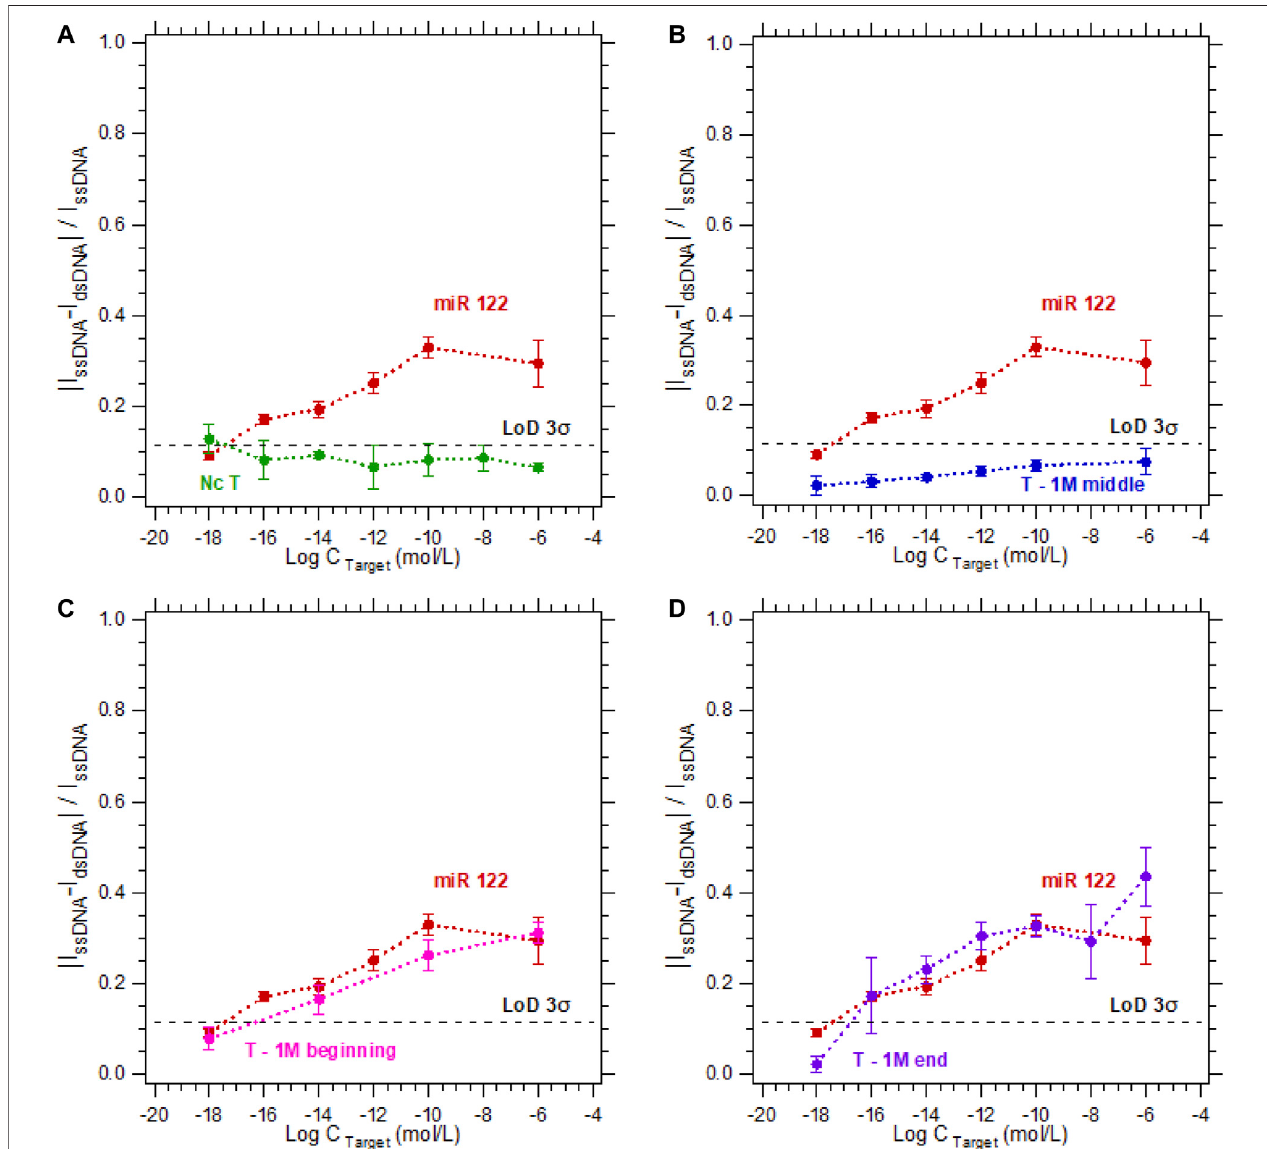
FIGURE 3 | Calibration curves in 3 mM [Fe (III) (CN) 6 ] 3 − /[Fe (II) (CN) 6 ] 4 − and 0.5 M NaCl for the detection of DNA target at concentrations varying from 10 − 18 M to 10 − 6 M.ForaDNAtargetcomplementarytotheDNAprobesequence(reddots — calledmiR122)comparedtothecalibrationcurvesof (A) anon-complementarytarget (green dots), (B) a sequence with a one-base mismatch located in the middle (blue dots), (C) at the beginning (pink dots), (D) or at the end (purple dots) of the strand.